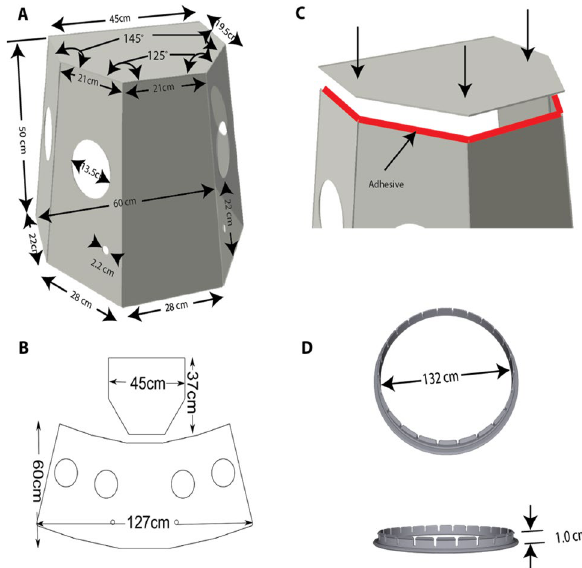
Figure 2. Configurations of the BADGER and grommet. ( a ) The BADGER has a tapered pentagonal shape with an overall height 50 cm and overall volume 95.8 L, four 135 mm diameter hand-ports and two 22 mm diameter outlets for filter placement. ( b ) The side panels can be constructed via bending or cutting into separate panels. ( c ) Top panel is glued to side panels using hot melt adhesive. ( d ) 3D-printed grommets, used to attach surgical gloves to the